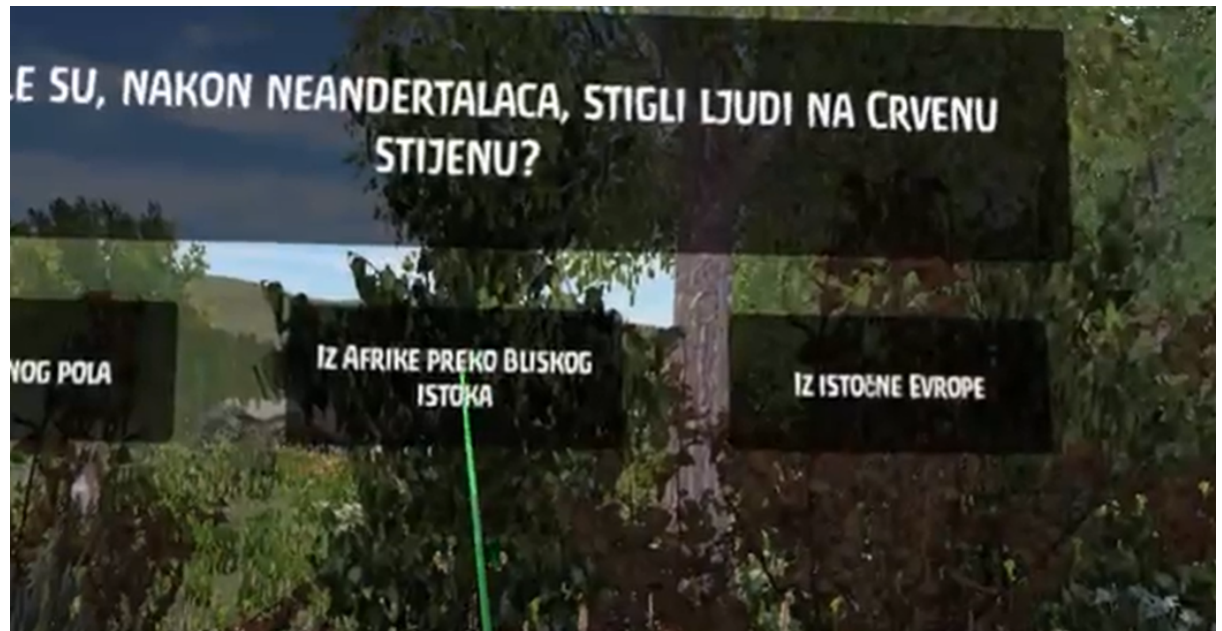
Figure 3. Interacting with the user interface via laser pointers on the Crvena stijena VR